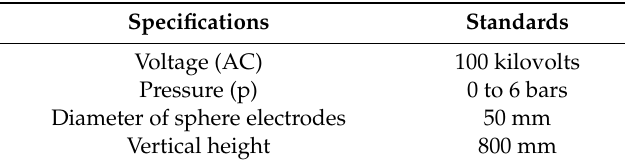
Table 5. Test setup specification.